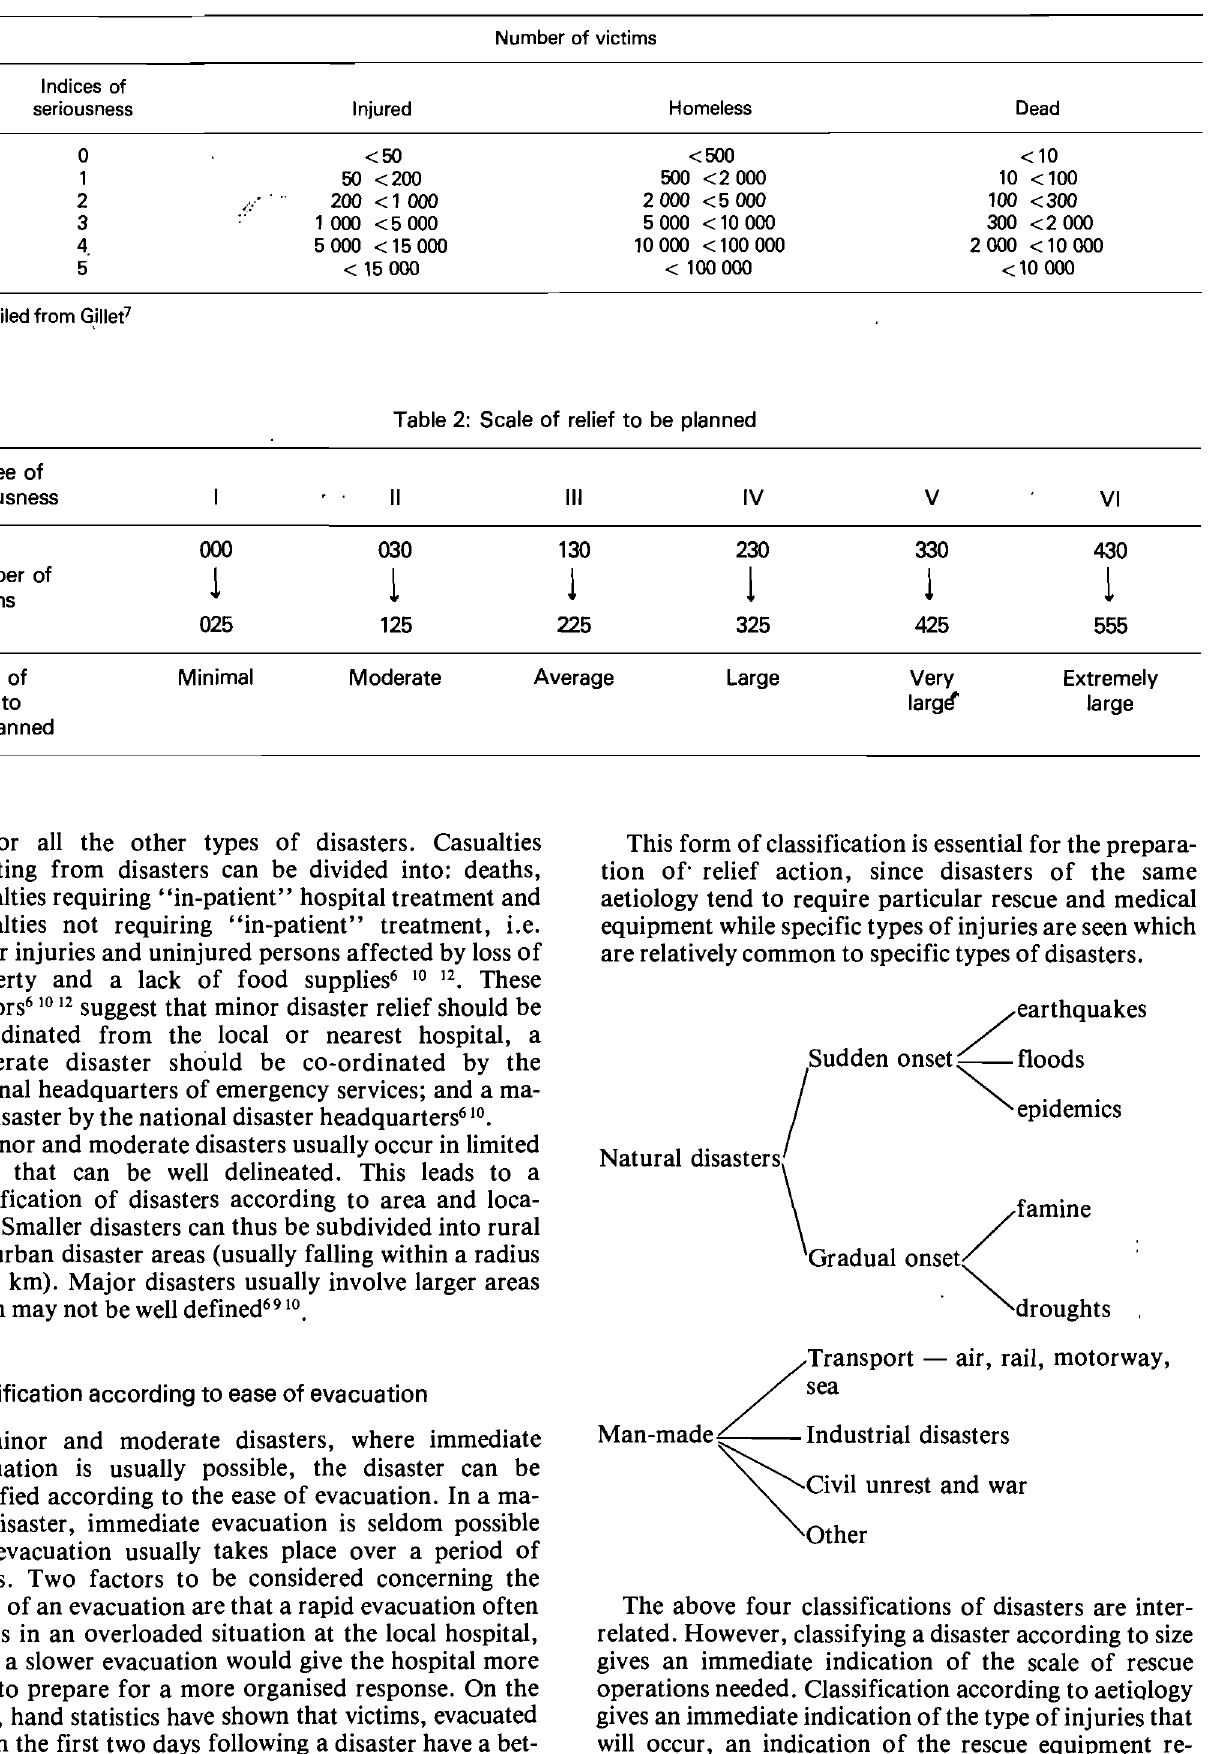
Table 1: Indicates the indices of seriousness according to the number of injured, homeless and dead